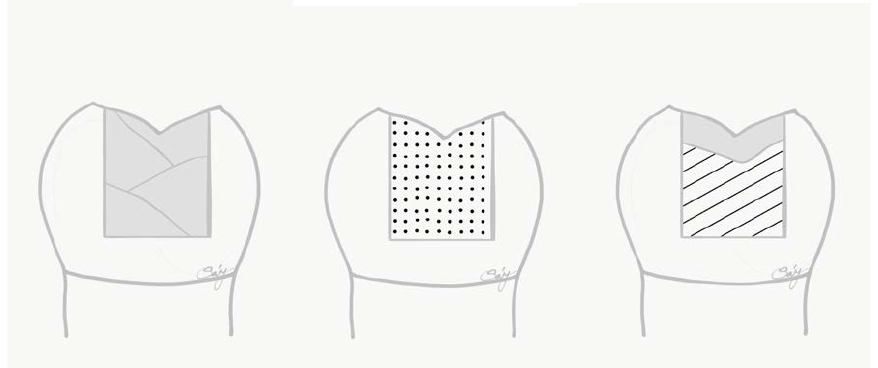
Figure 1. Schematic figure representing the test groups (from left to right). Group 1: layered con- ventional packable composite filling; Group 2: bulk-fill composite filling; Group 3: bulk-fill SFRC and conventional packable composite occlusal coverage.